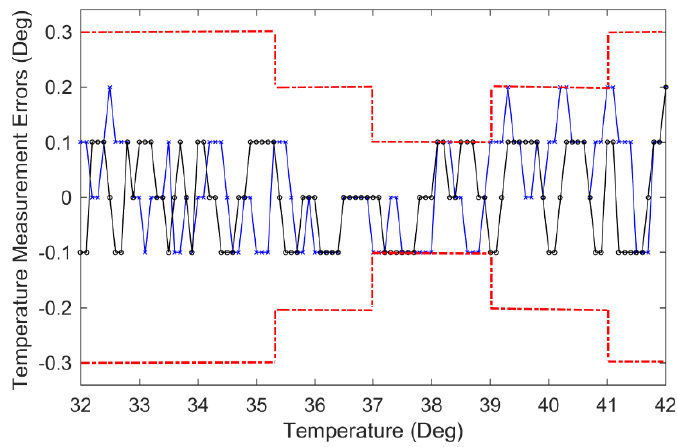
Figure 15. Test result comparison: × — blue line: upstroke errors; ο — black line: downstroke errors; red dotted line: allowable error thresholds by the related regulations in China.